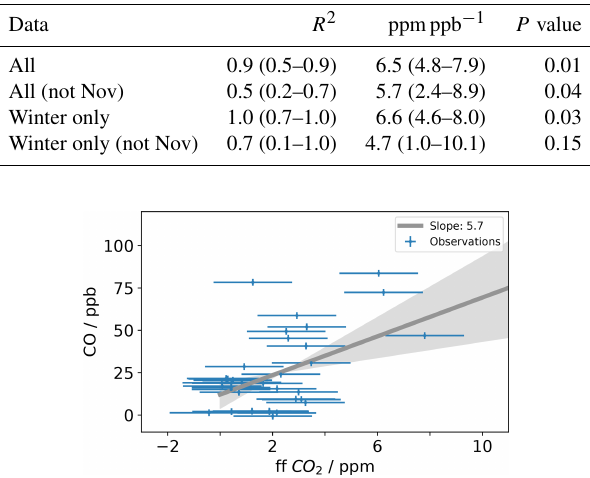
Figure 5. This figure shows the CO enhancement (CO enh ) at TAC (Sect. 4.2.3) against the observed ffCO 2 derived from (cid:49) 14 CO 2 measurements. The slope of the linear regression is used to calculate the CO enh / ffCO 2 ratio at TAC. The grey line shows the linear re- gression and grey shading shows the 5%–95% uncertainty estimate of the linear regression. Results of the linear regression calculation of different subsets of this dataset can be found in Table